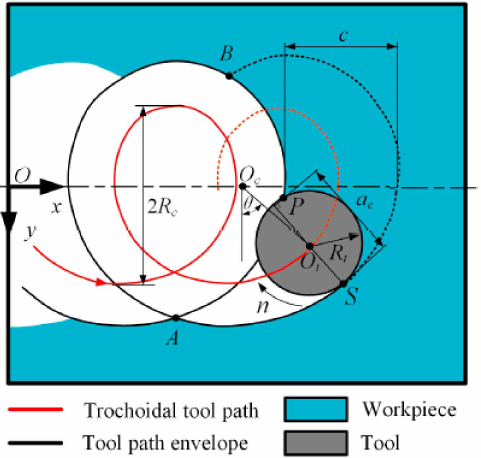
Figure 10. Example of a geometric model of trochoidal milling [79].